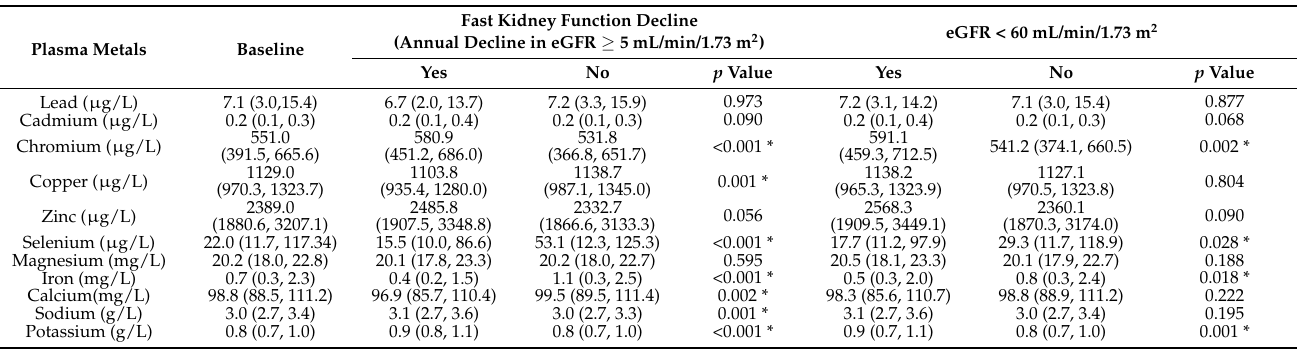
Table 2. Plasma metals’ concentration of different eGFR groups ( n = 1368, median (interquartile